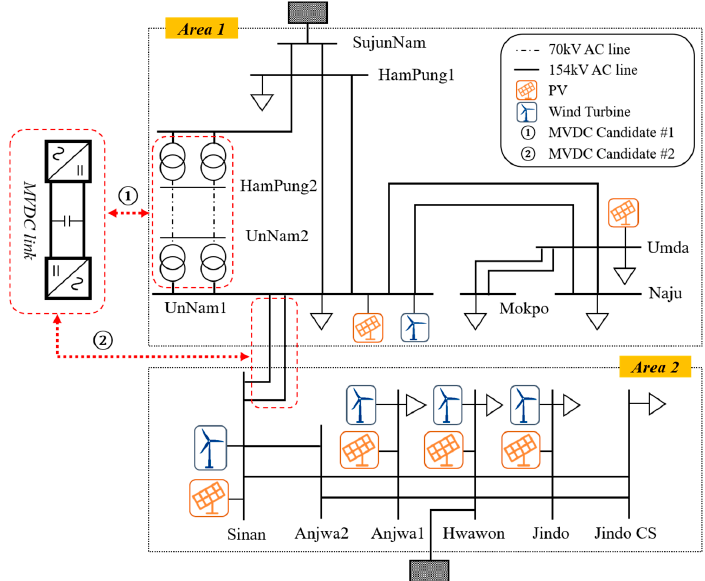
Figure 3. Representation of MVDC link candidates in the Korean power system.